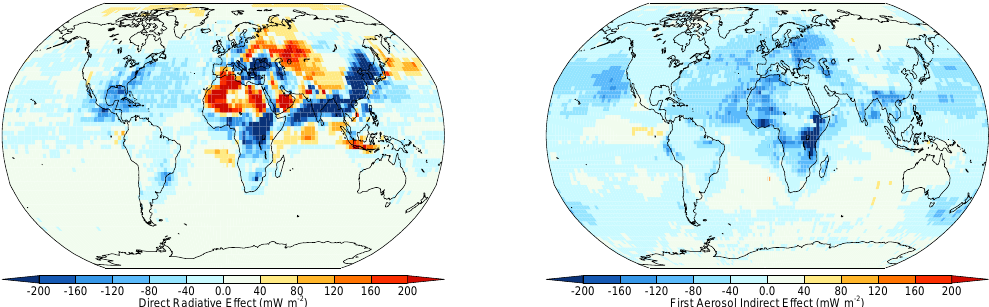
Figure 14. Annual mean all-sky direct radiative effect (DRE) (left panel) and first aerosol indirect effect (AIE) (right panel) due to residential emissions (res_base), relative to an equivalent simulation where residential emissions have been removed (res_base_off).